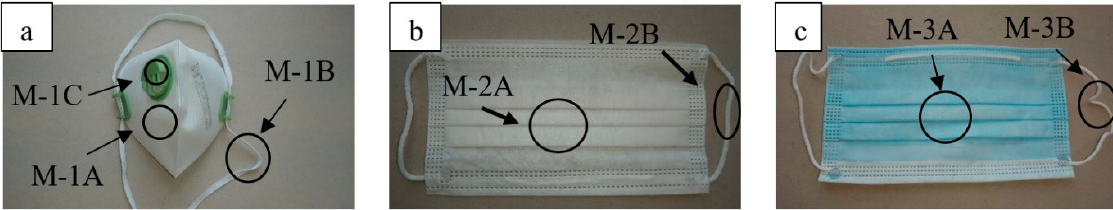
Figure 1. Photos of the face masks and sample denotation: ( a ) multi-layer mask with an FFP3 breathing valve; ( b ) three-layer mask made by the melt-blown method; ( c ) surgical mask made in China.